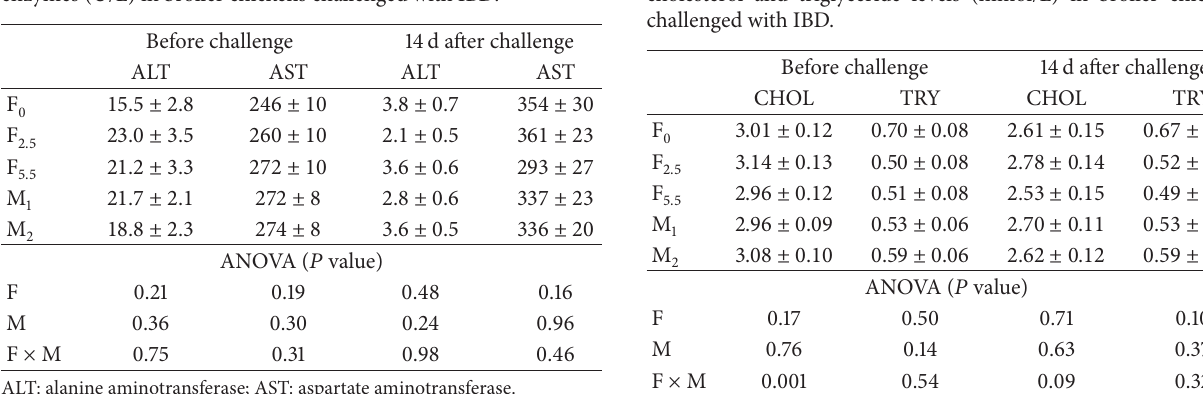
Table 5: Effect of fish oil and methionine supplementation on liver enzymes (U/L) in broiler chickens challenged with IBD.